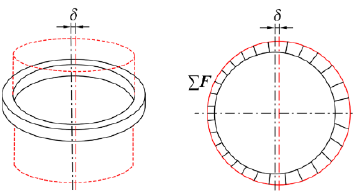
Figure 4. Contact pressure distribution of